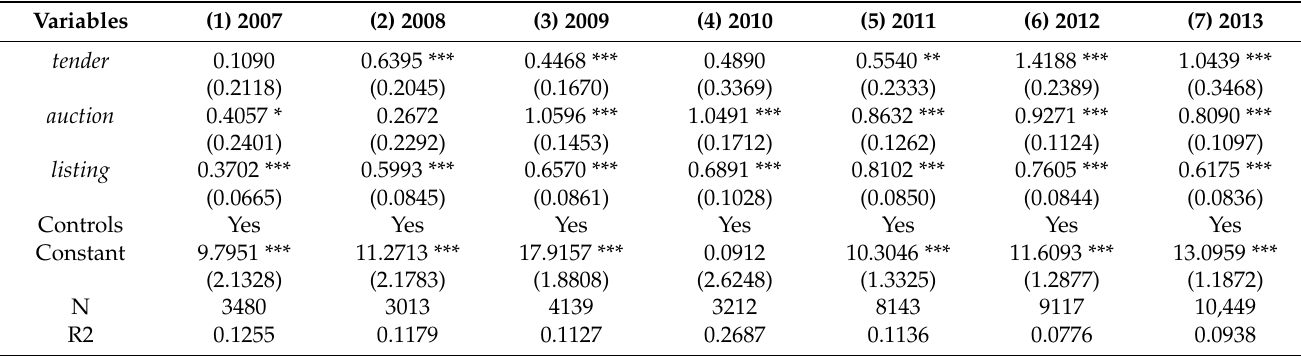
Table A8. Influence of industrial land transfer modes on enterprises’ willingness to bid